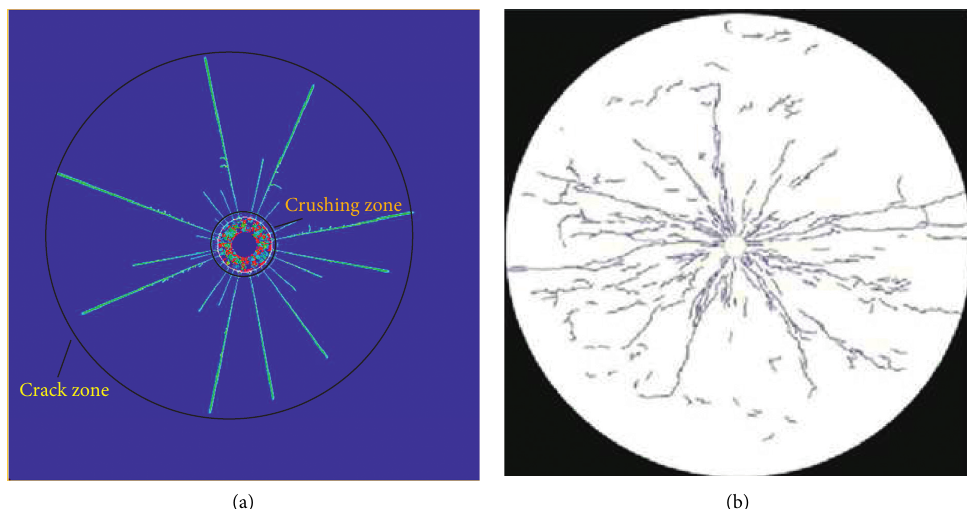
Figure 7: Comparison between the numerical simulation and the experimental result by Banadaki and Mohanty [21]. (a) Crack pattern of numerical model. (b) Crack pattern of rock experiment (Banadaki and Mohanty 2010) [21].